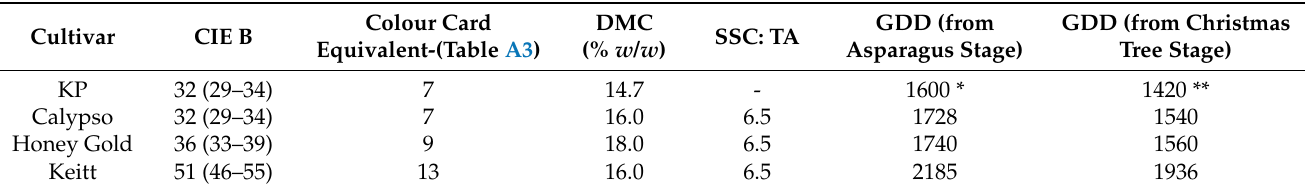
Table 11. Recommended minimum harvest maturity specifications by cultivar, based on use of the Upper T calculation of